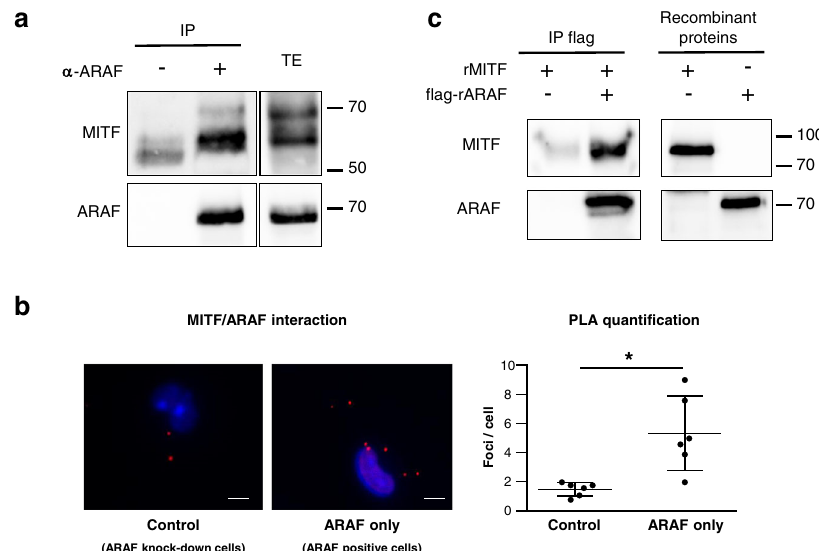
Fig. 2 Validation of the ARAF/MITF interaction. a Identi fi cation of endogenous ARAF/MITF complexes by co-immunoprecipitation. ARAF-only cells extracts were immunoprecipitated with an anti-ARAF antibody. Immune complexes (IP) and total extracts (TE) were immunoblotted with anti-MITF and anti-ARAF antibodies. b Identi fi cation of endogenous ARAF/MITF complexes by Proximity Ligation Assay. ARAF/MITF complexes were visualized as red dots in ARAF-only cells compared to control cells expressing an shRNA against ARAF by using a fl uorescence microscope. Cell nuclei were stained with DAPI. Scatter plots show the average number of dots per cell (at least 148 nuclei were observed) from six microscopic fi elds and are representative of three different experiments. Means with standard deviations are shown. * p value = 0.0019 compared by unpaired t test with Welch ’ s correction. Representative pictures from three independent experiments are shown. Scale bar: 100 µ m. c Identi fi cation of a direct ARAF/MITF interaction by in vitro coimmunoprecipitation. Recombinant MITF and fl ag-tagged ARAF proteins were incubated in NP40 Buffer. ARAF was immunoprecipitated with an anti- fl ag antibody. Immune complexes and recombinant proteins were blotted with anti-MITF and anti-ARAF